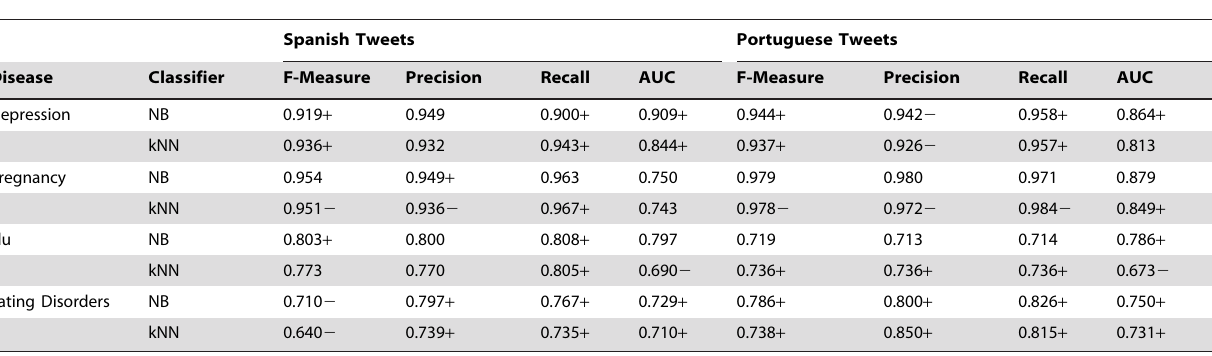
Table 9. Classification results obtained on subsets generated using Gain Ratio.